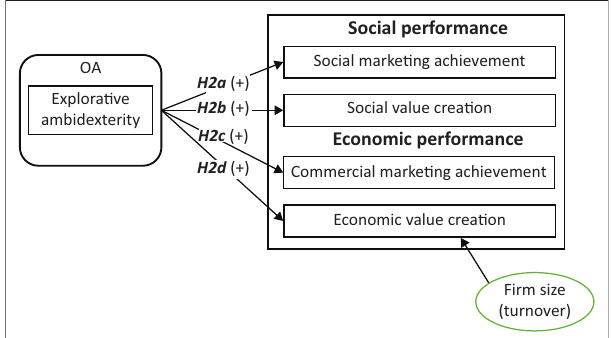
FIGURE 2: Conceptual model of the explorative ambidexterity – social enterprise performance